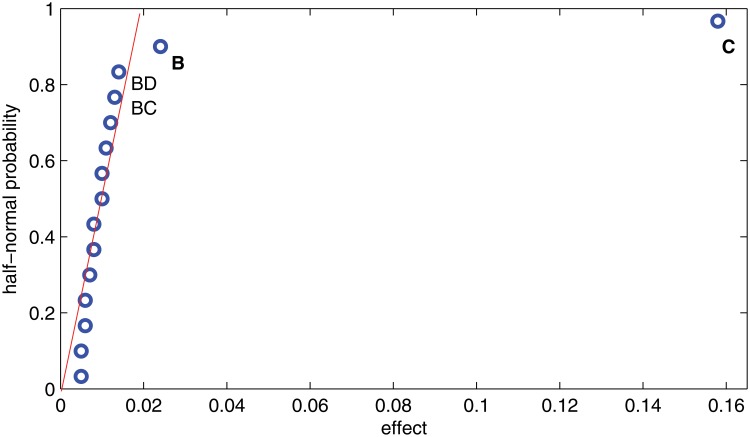
Half-normal plot of effects for Y
p.